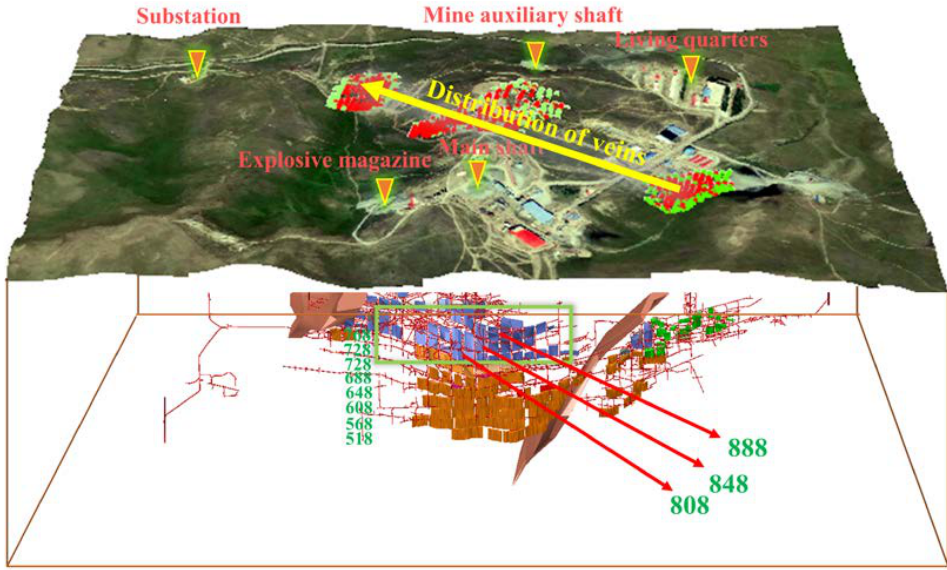
Figure 8. Schematic diagram of the ore body and surface subsidence in the mine area. (Image of the mine’s surface is taken from Google Maps).